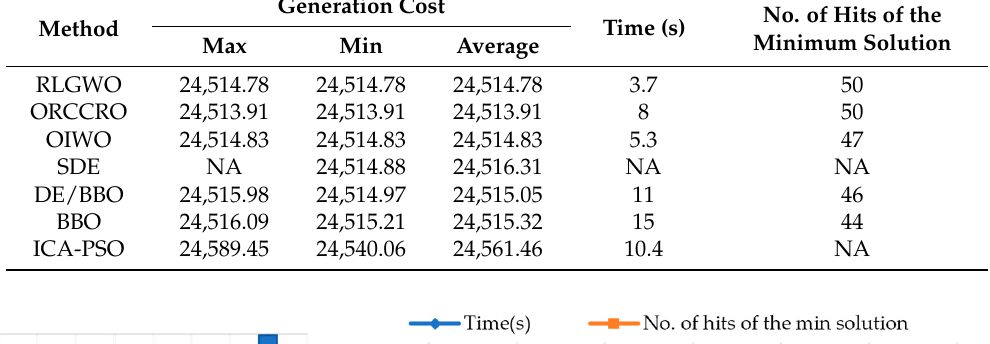
Table 2. Comparison between different methods taken after 50 trials (13 ‐ unit system with loss).